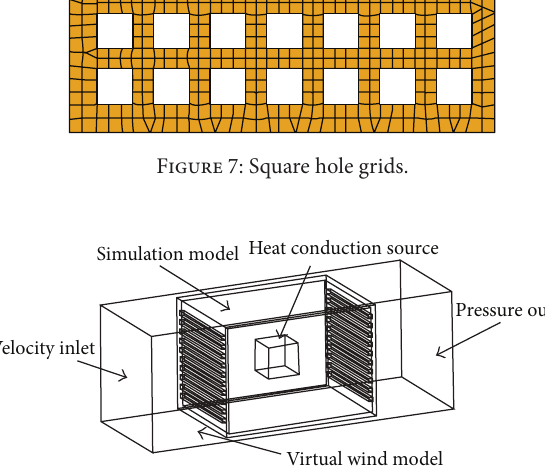
Figure 8: CFD model for numerical simulation.